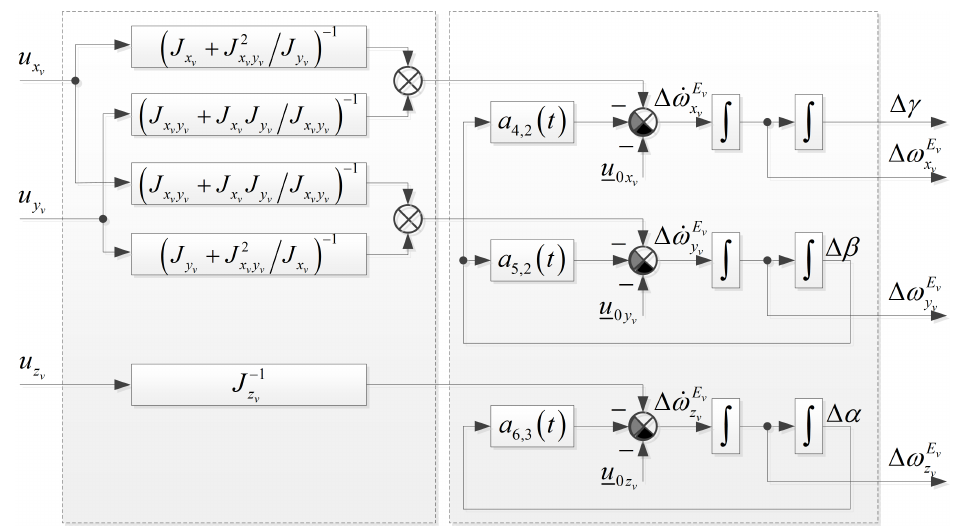
Figure 1. Onboard model of the spacecraft angular